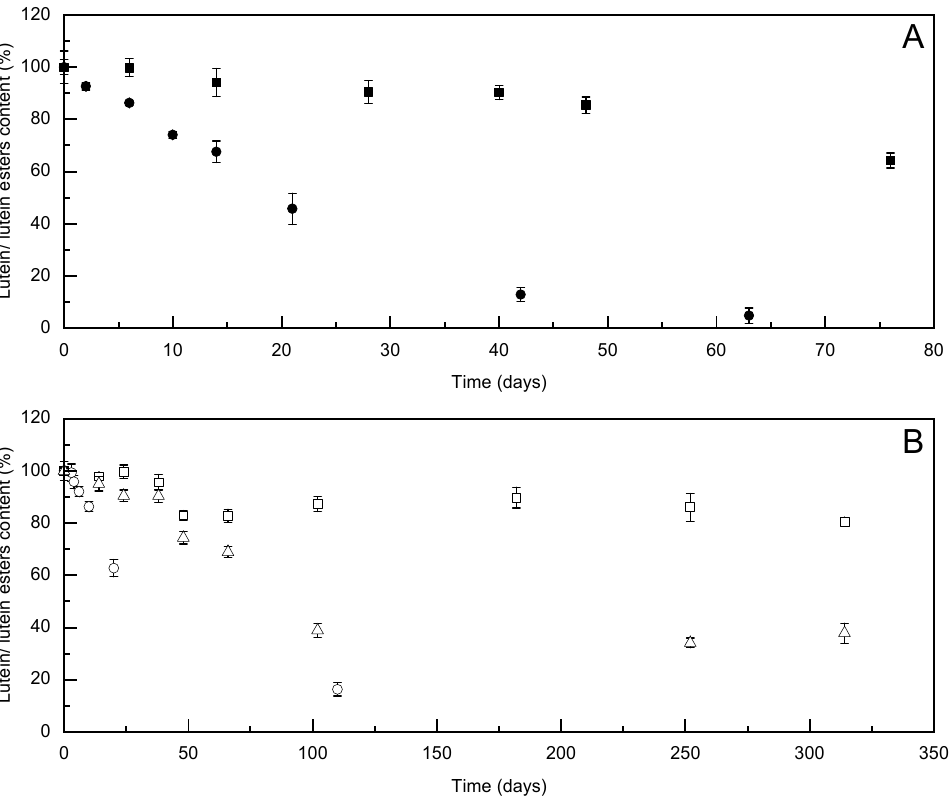
Figure 2. ( A ) Stabilities of lutein extract ( ● ) and lutein esters extract ( ■ ) when stored in sealed dark containers at 4 °C. ( B ) Stabilities of formulation 2L with lutein (fine suspension, ○ ) and formulations 1LE (paste, △ ) and 2LE (fine suspension, □ ) with lutein esters when stored in sealed dark containers at 25 °C. Data are means ± SD ( n = 3).